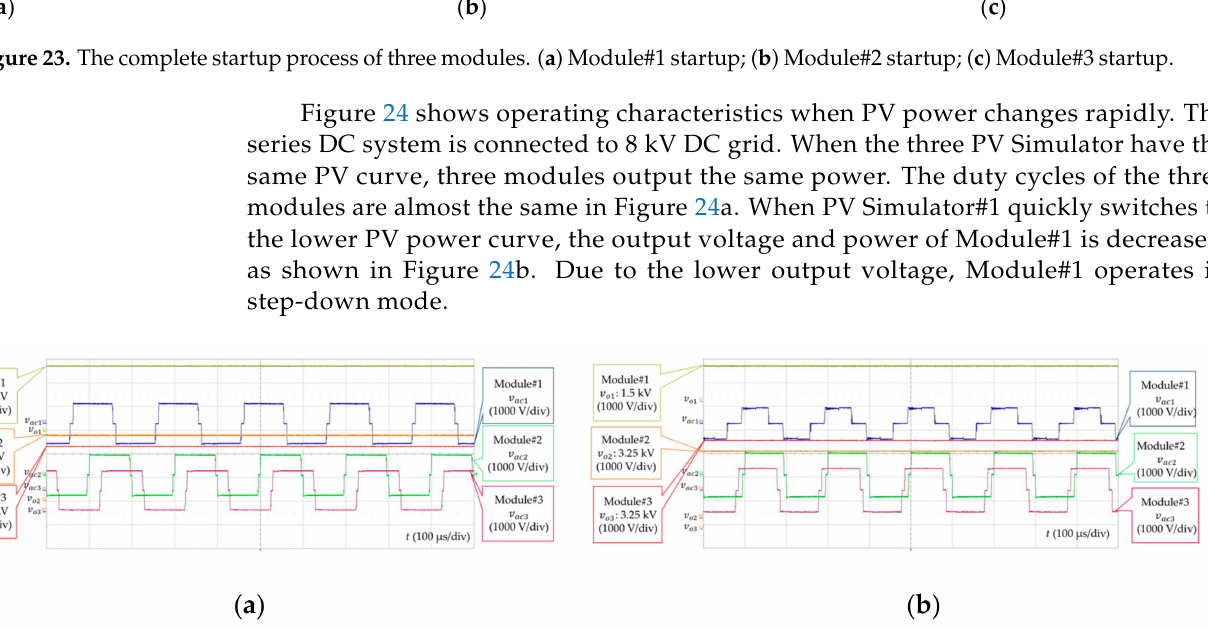
Figure 23. The complete startup process of three modules. ( a ) Module#1 startup; ( b ) Module#2 startup; ( c ) Module#3 startup.